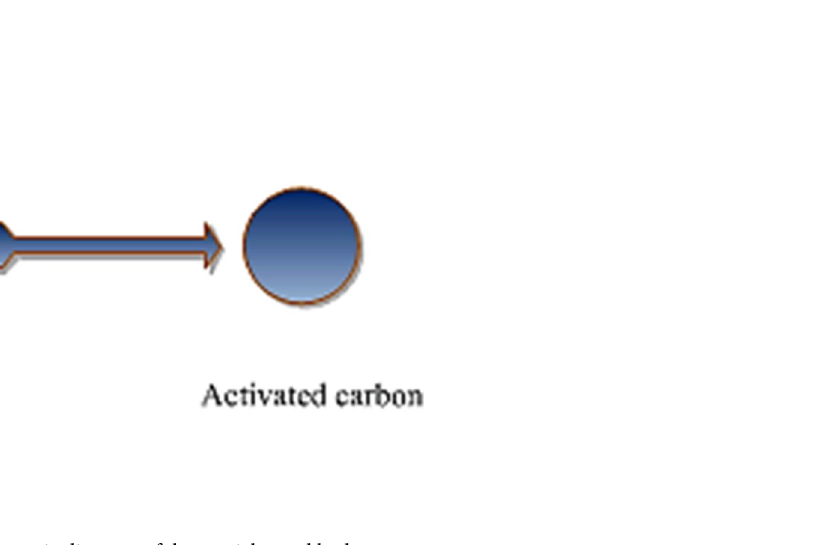
Figure 11. A schematic diagram of the particles and